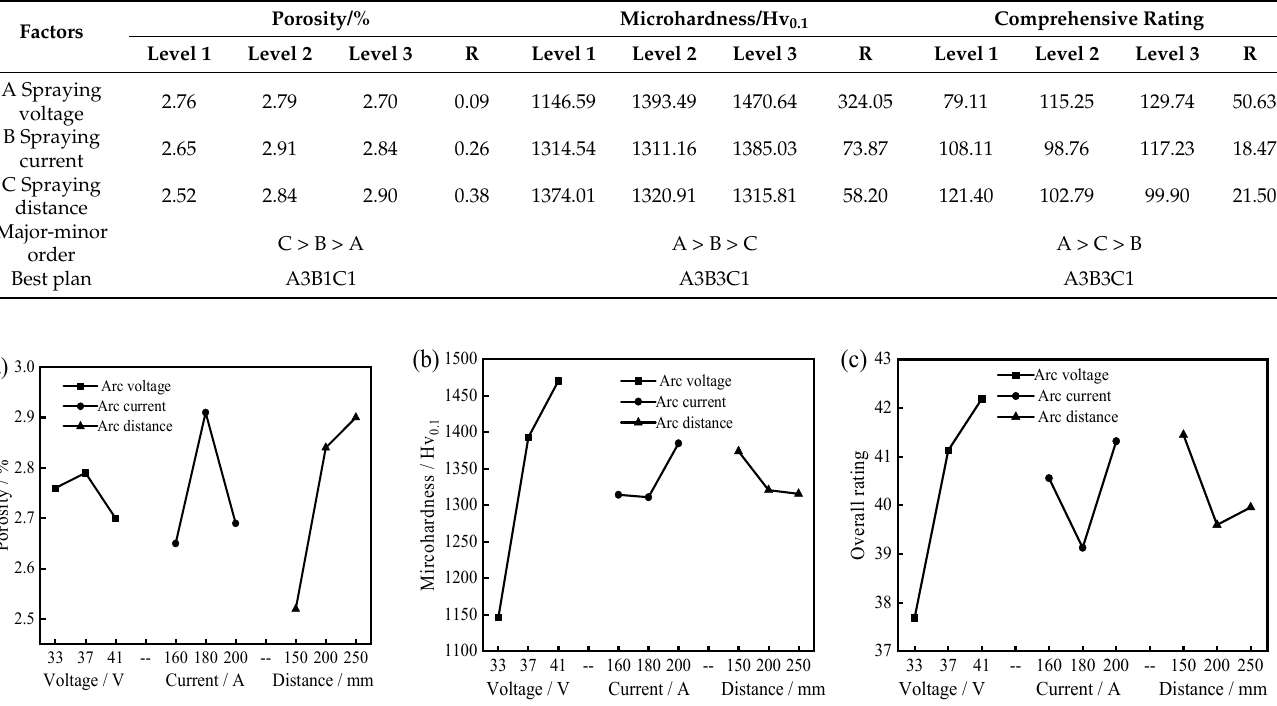
Table 5. Range analysis results of Orthogonal tests.